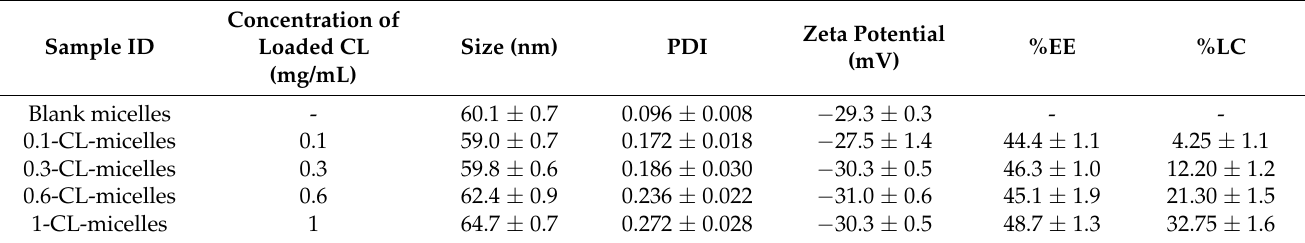
Table 2. Size, PDI values, Zeta-potential, encapsulation efficiency (%EE) and loading capacity (%LC) of NBSCh micelles using NBSCh 1